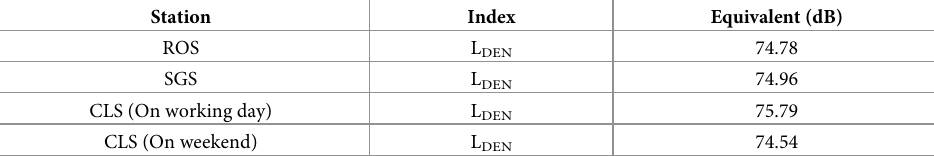
Table 12. The mean equivalent value of LDEN noise levels at each of the three selected